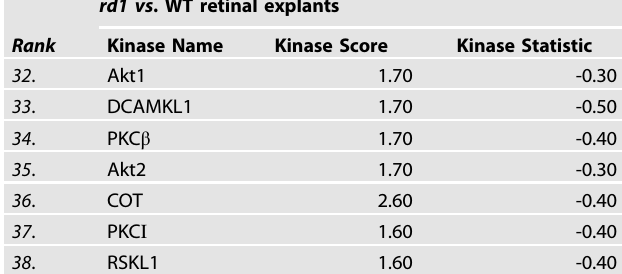
Table 1. Upstream kinase analysis results for rd1 vs . WT and rd1 CN03 vs . rd1